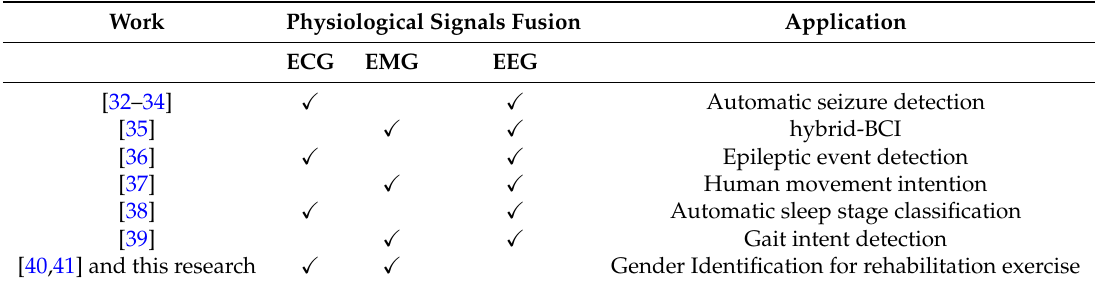
Table 2. Most related work for the fusion of physiological